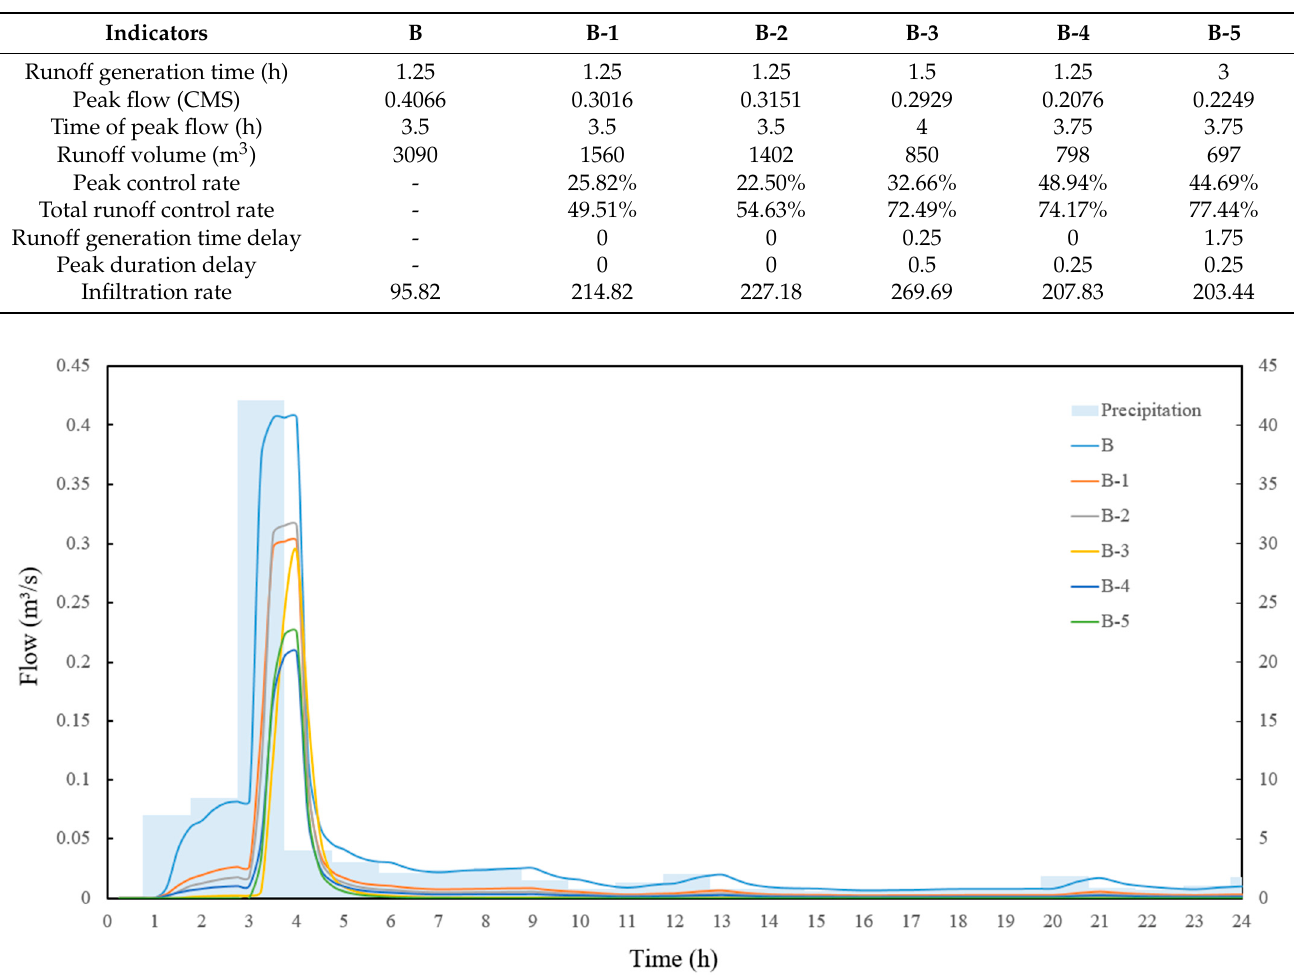
Table 4. Degree of performance improvement for 5 “what-if” scenarios in block mode compared to the current situation.